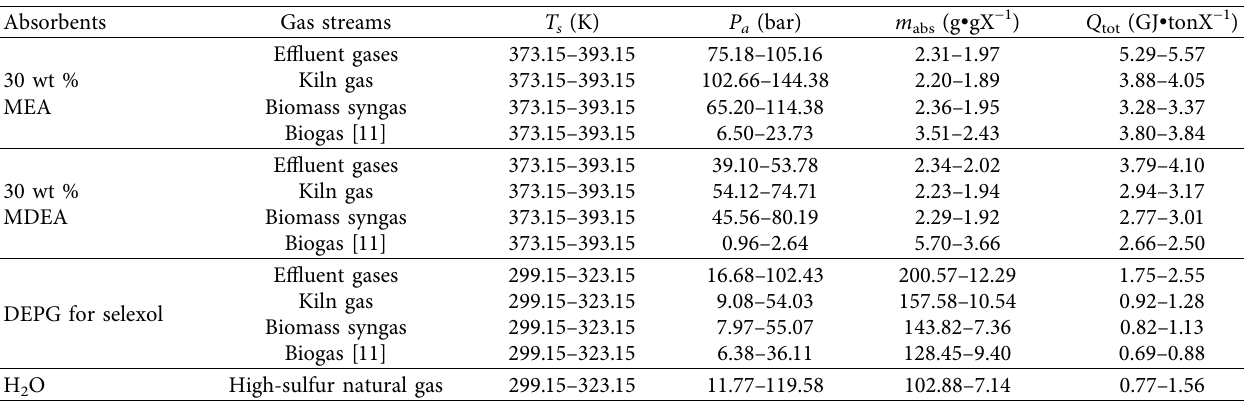
Table 4: Te optimal conditions ( T